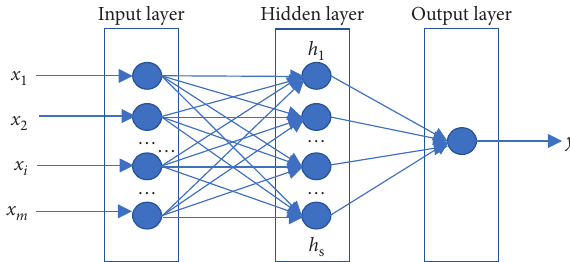
Figure 4: The construction of a typical three-layer MLP